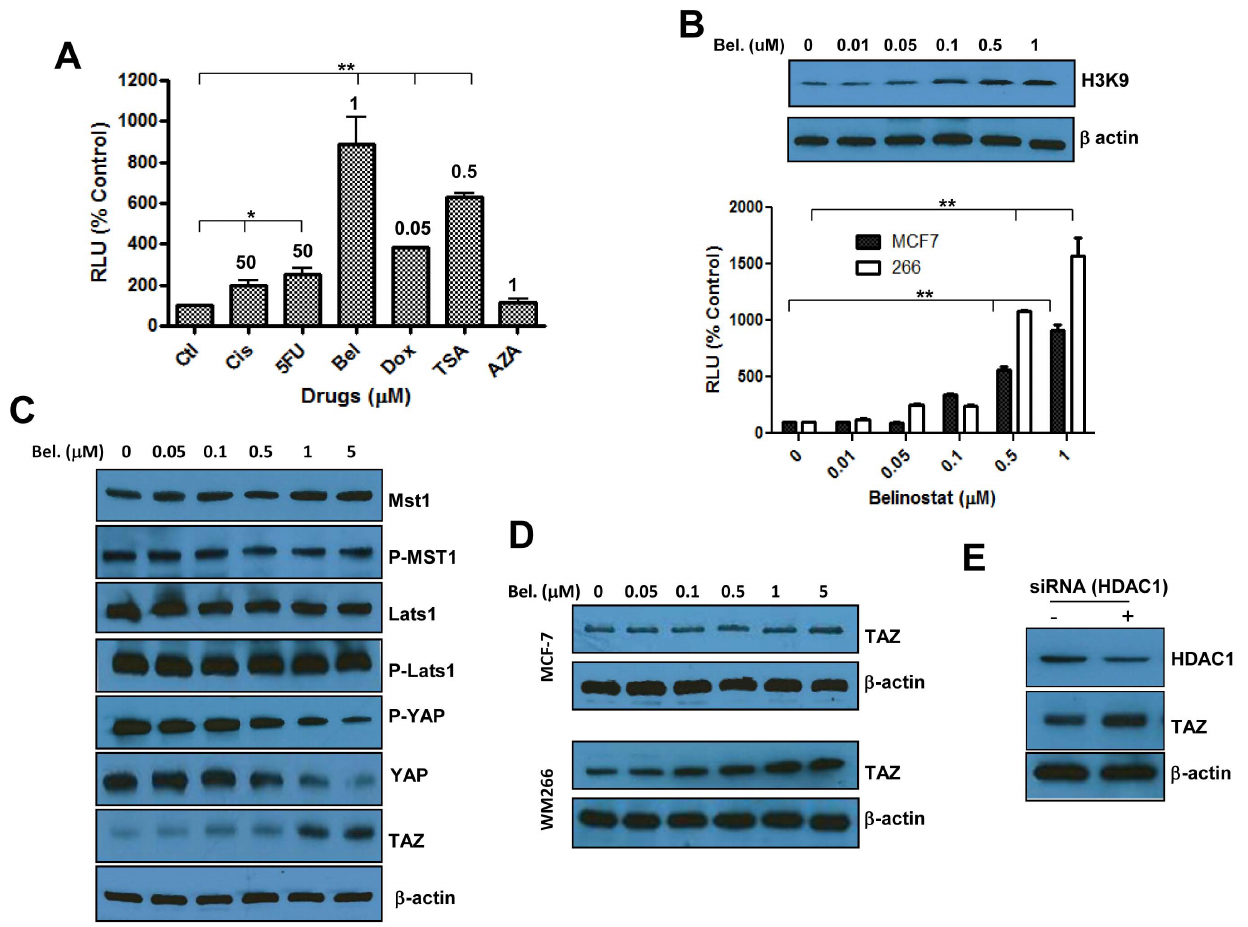
Figure 1. Respective roles of DNA damage and chromatin modification in regulation of the Hippo pathway. Panel A. Hippo reporter activity in response to drugs tested at concentrations that induce 50% inhibition of proliferation in SW480 cells (indicated at the top of each bar). Ctl: control., Cisp: cisplatin., Dox: doxorubicin., Bel: Belinostat., TSA: Trichostatin A., AZA: 5 Azacitidine(decitabine)). Panel B. Western blot showing the effect of Belinostat on acetylation of Histone H3 at Lysine 9 (H3K9) (Upper level), and activity of Hippo reporter in MCF7 and WM 266 melanoma cells. Each bar in Panels A and B represents the average of three determinations 6 SE. Statistical significance is shown for drug-treated cells compared to the corresponding untreated controls (*p , 0.05, **p , 0.001). Panel C. Western blots depicting the effect of Belinostat on expression and/or phosphorylation of various components of the Hippo pathway in SW480 cells. Panel D. Expression of TAZ in MCF7 and WM 266 cells in response to Belinostat. Panel E. Representative data showing the effect of siRNA mediated Knockdown of HDAC1 on expression of TAZ in WM266 cells measured by Western blot.